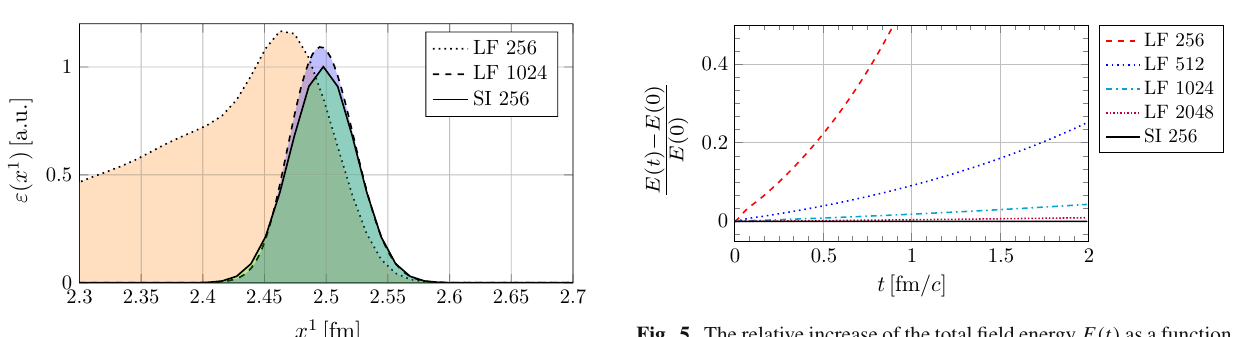
Fig. 5 The relative increase of the total field energy E ( t ) as a function of time t for the propagation of a single nucleus in a box of volume V = ( 3fm ) × ( 6fm ) 2 with a longitudinal length of 3fm and a trans- verse area of ( 6fm ) 2 . The lattice size is N L × N 2 with the transverse T lattice fixed at N T = 256. Starting with the same initial condition, we evolve forward in time using the leapfrog (LF) and the semi-implicit (SI) method. In the case of the leapfrog scheme we vary the resolu- tion along the beam axis using the number of longitudinal cells N L of the lattice. For N L = 256 the numerical Cherenkov instability leads to catastrophic failure, increasing the energy to many times its original value. The effect is suppressed when increasing the longitudinal reso- lution, but the instability is still present. In the case of the semi-implicit scheme it is possible to set N L = 256 and still obtain (approximate) energy conservation. After t = 2fm / c the energy increase for the semi- implicitschemeisroughly0 . 02%,comparedto1%fortheleapfrogwith N L = 2048. For the simulation using the semi-implicit scheme we used N i = 10 iterations and a damping coefficient of α = 0 . 45. The time step is set to the longitudinal lattice spacing. In the case of the leapfrog simulation we used a 0 = a 1 /